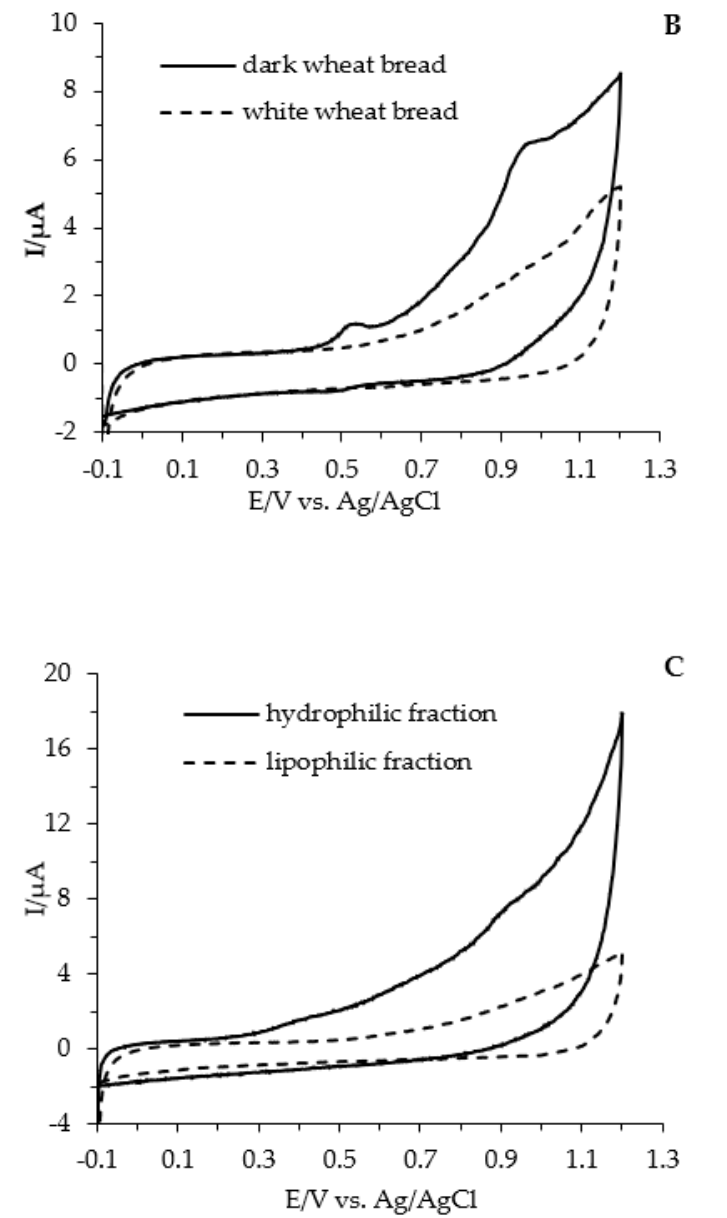
Figure 2. Cyclic voltammograms of hydrophilic extracts originated from white and dark rye flour ( A ), cyclic voltammograms of hydrophilic extracts of slices originated from white and dark wheat bread (200 °C/35 min.) ( B ), cyclic voltammograms of the hydrophilic and lipophilic fraction of crust separated from white wheat bread (240 °C/35 min.) ( C ). Concentration of extract: 100 mg/mL; sample preparation: hydrophilic fraction: aqueous methanol (1:4, v/v ) extract mixed with 0.2 M acetic buffer (pH 4.5) at ratio 1:1 ( v/v ); lipophilic fraction: methanol/hexane 4:1 ( v/v ) extract mixed with 0.2 M acetic buffer (pH 4.5) at ratio 1:1 ( v/v ); and scan rate 100 mV/s.